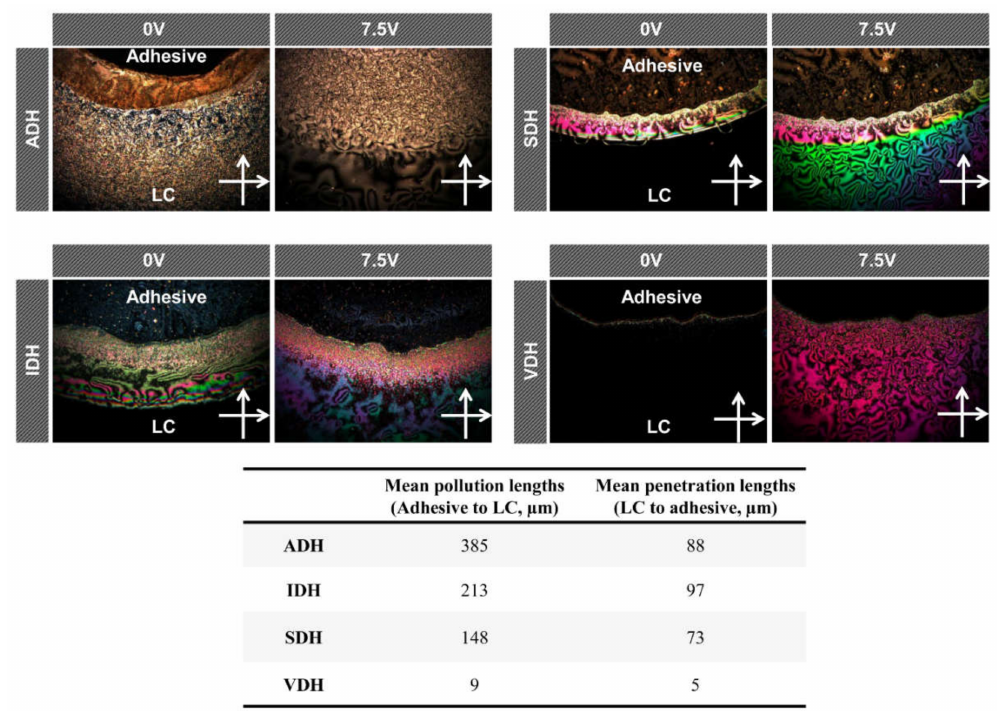
Figure 7. Contact contamination results of various epoxy resin systems. The liquid crystal (LC) texture area indicates contact contamination at 0